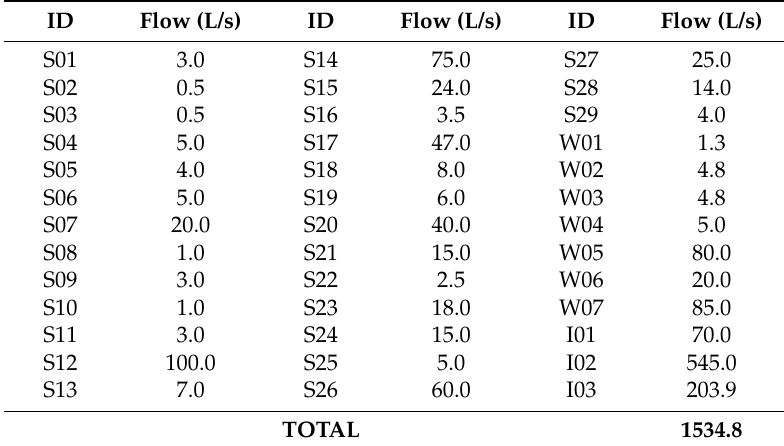
Table 1. Source nodes in the province of Crotone (“S” means spring, “W” well, “I” intake). ID Flow (L/s)